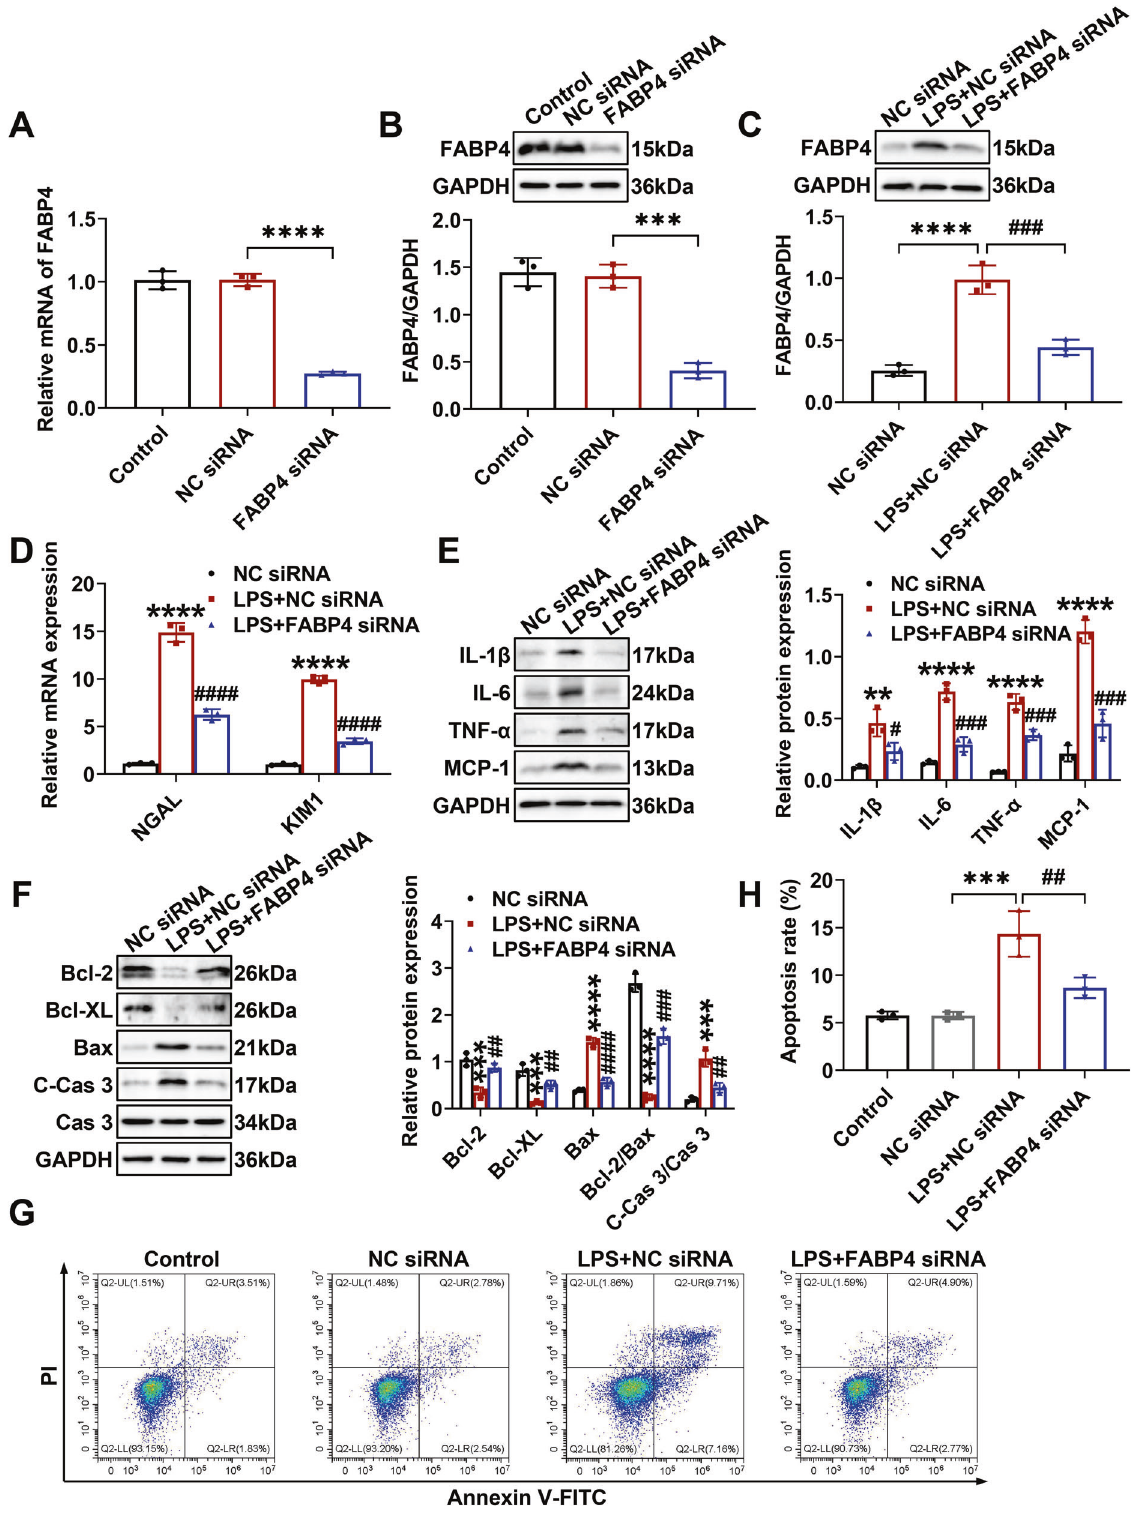
Fig. 5 FABP4 knockdown inhibited in fl ammation and apoptosis in LPS-stimulated TCMK-1 cells. TCMK-1 cells were transfected with negative control (NC) siRNA or FABP4 siRNA for 24 h and then treated with 100 μ g/ml LPS for another 24 h. The knockdown ef fi ciency of FABP4 siRNA in TCMK-1 cells was evaluated by ( A ) quantitative real-time PCR analysis and ( B ) western blot analysis. C Representative western blot images and quantitative analysis of FABP4 in TCMK-1 cells. D The mRNA levels of NGAL and KIM1 detected by quantitative real-time PCR. Western blotting and densitometry quanti fi cation of ( E ) in fl ammatory factors including IL-1 β , IL-6, TNF- α , and MCP-1, and ( F ) apoptotic marker including Bcl-2, Bcl-XL, Bax, caspase 3 (Cas 3), and cleaved-caspase 3 (C-Cas 3) in TCMK-1 cells. G Representative fl ow cytometric plots of TCMK- 1 cell apoptosis and ( H ) quanti fi cation of apoptosis rate. All data are displayed as mean ± SD ( n = 3); ** P < 0.01, *** P < 0.001 , **** P < 0.0001 versus NC siRNA; # P < 0.05, ## P < 0.01, ### P < 0.001, #### P < 0.0001 versus LPS + NC